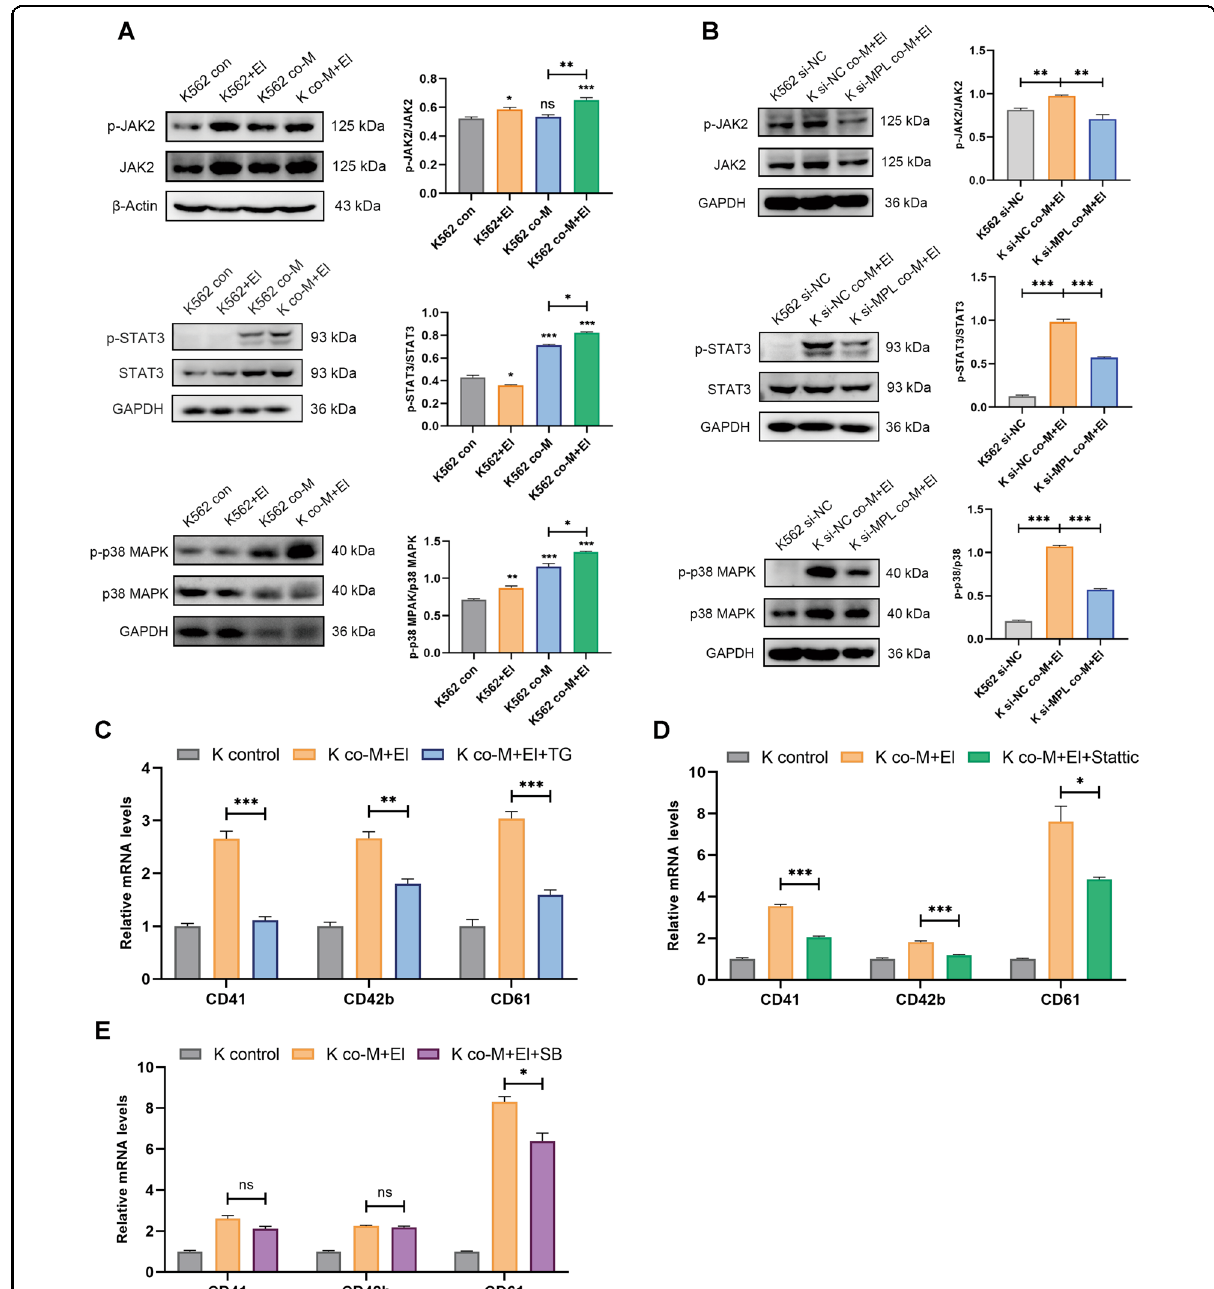
Fig. 6 MSCs and El-activated CML cell differentiation through JAK2/STAT3 and p38 MAPK pathways. A The protein levels of correlated signaling pathways and phosphorylation status were measured by western blotting after treatment with either MSCs or El alone or the combination for 48 h. GAPDH or β -Actin was used as a control. B K562 cells were transfected with siRNA negative control (K562 si-NC) or MPL-siRNA (K562 si-MPL). The K562 si-NC or K562 si-MPL cells were cultured alone or co-cultured with MSCs and El. After 2 days, protein levels of correlated signaling pathways and phosphorylation status were measured by Western blotting. GAPDH was used as a control. C K562 cells were treated with the JAK2 inhibitor TG101209 (TG) (1 μ M) followed by co-culturing with MSCs for 48 h. The mRNA expression of differentiation markers was determined by RT-PCR ( n = 3). D K562 cells were treated with the STAT3 inhibitor Stattic (5 μ M) followed by co-culturing with MSCs for 48 h. The mRNA expression of differentiation markers was determined by RT-PCR ( n = 3). E K562 cells were treated with the p38 MAPK inhibitor SB239063 (SB) (10 μ M) followed by co-culturing with MSCs for 48 h. The mRNA expression of differentiation markers was determined by RT-PCR ( n = 3). All statistical data in this fi gure represented the mean ± SEM (* P <0.05, ** P <0.01, *** P <0.001, ns, not signi fi cant, by one-way ANOVA in A and by Student ’ s t test in B – E ). El: eltrombopag, TG: TG101209, SB: